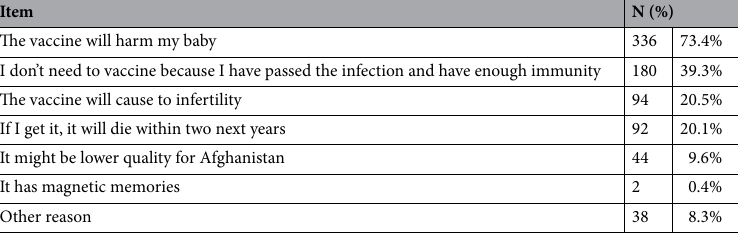
Table 3. Reasons for hesitancy to take the COVID-19 vaccine (N = 492).